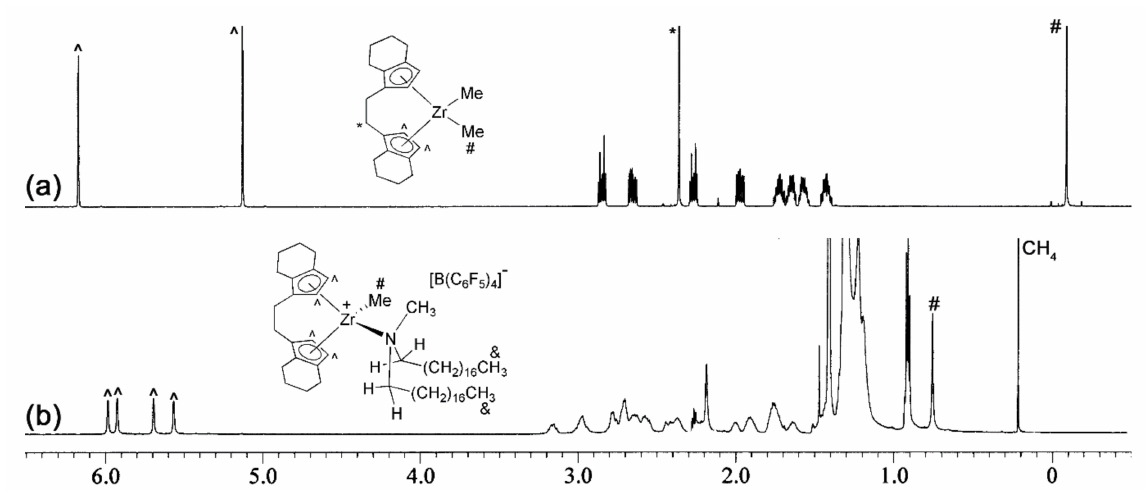
Figure 4. 1 H NMR spectra of 1 -ZrMe 2 ( a ) and its activated complex [ 1 -Zr(Me)(N(Me)(C 18 H 37 ) 2 )] + [B(C 6 F 5 ) 4 ] − ( b ). Signals marked with ˆ, *, and # characters correspond to protons marked with those characters in the